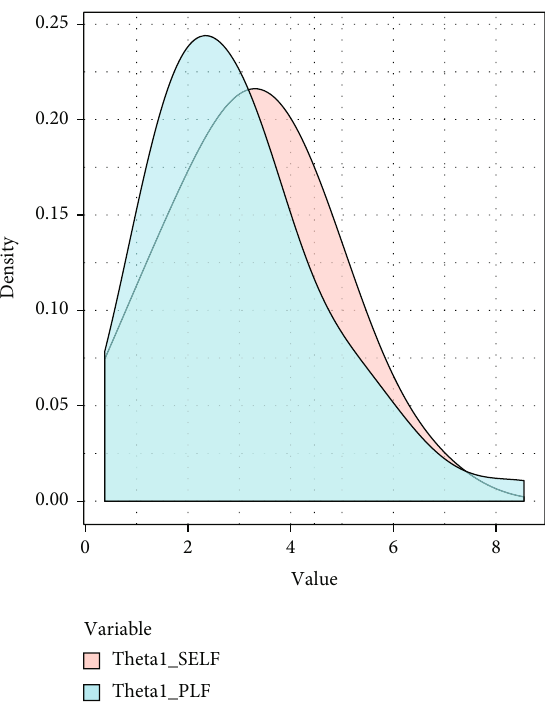
Figure 1: The marginal density for θ